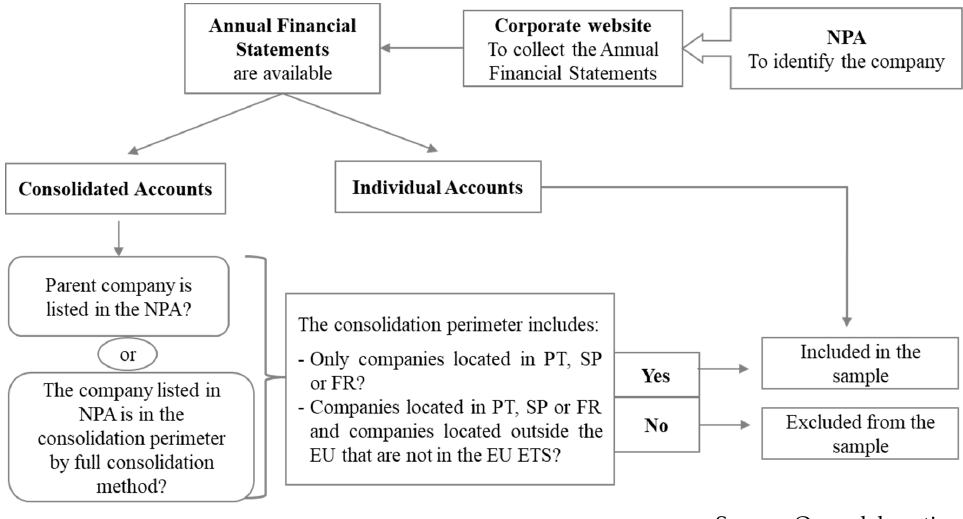
Figure 1. Summary of sample selection. FR, France; PT, Portugal; SP, Spain; NPA, National Plans of Allocation.